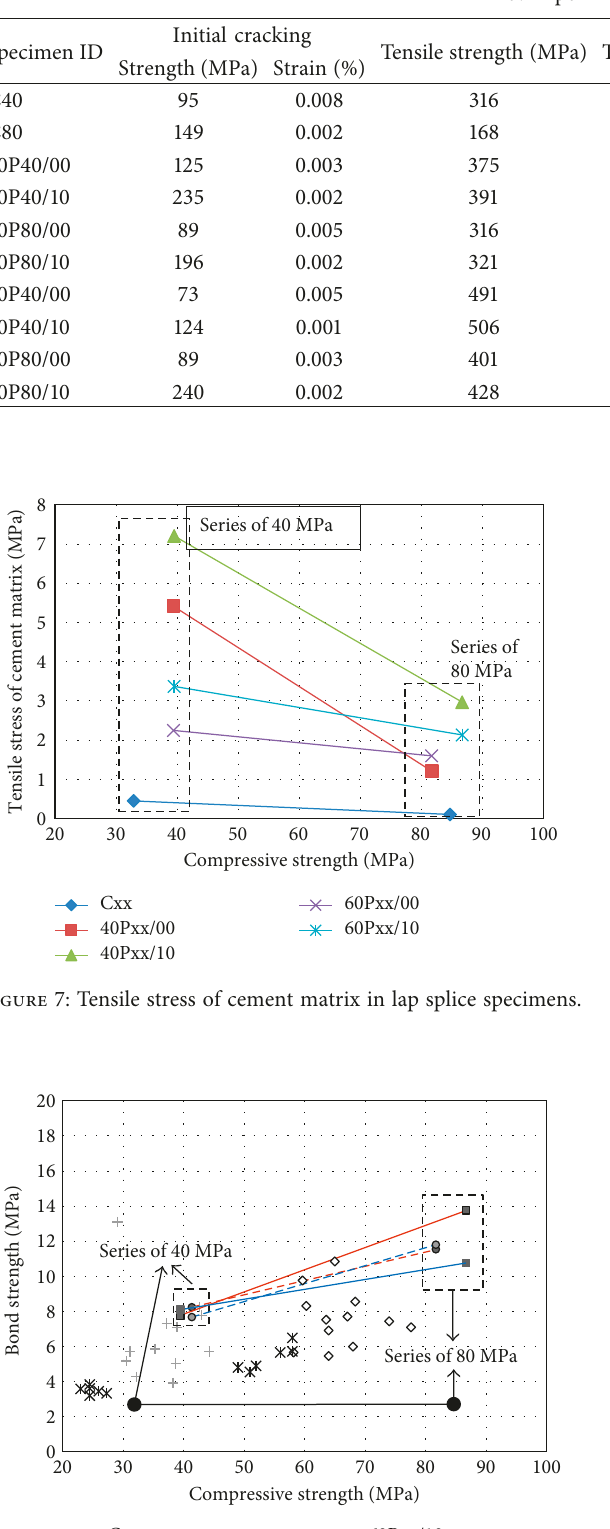
Table 5: Experimental test results.